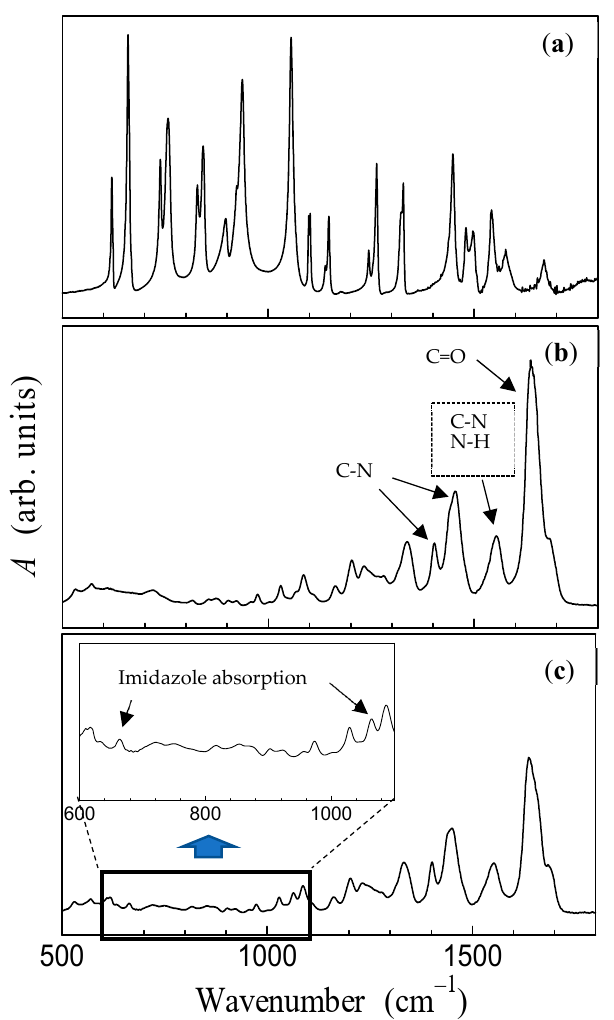
Figure 4. FT-IR spectra in imidazole ( a ), collagen ( b ), and imidazole–collagen composite ( c